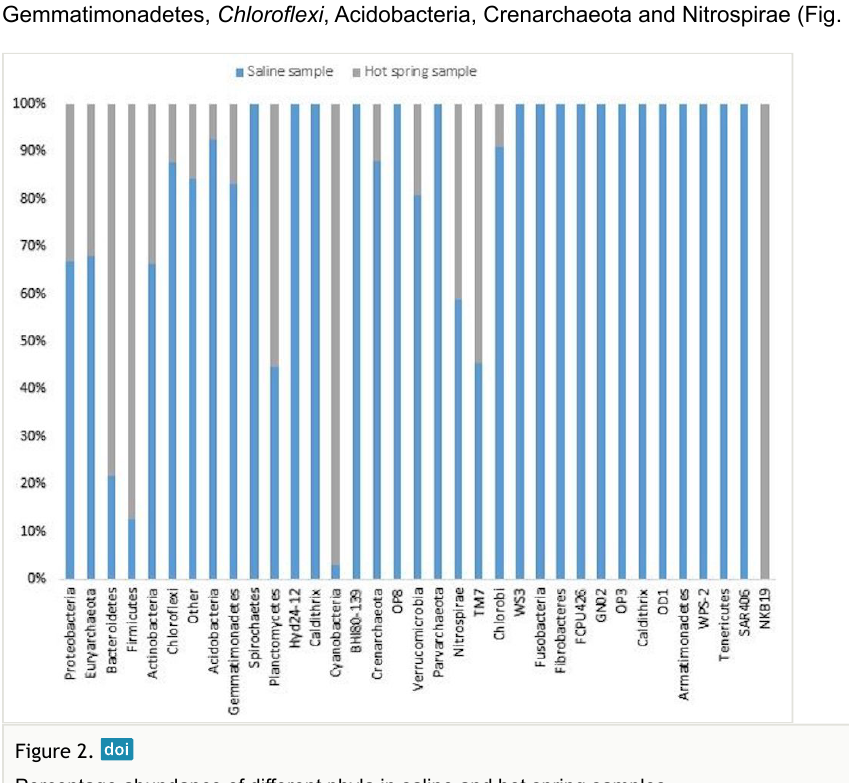
Figure 2. Percentage abundance of different phyla in saline and hot spring